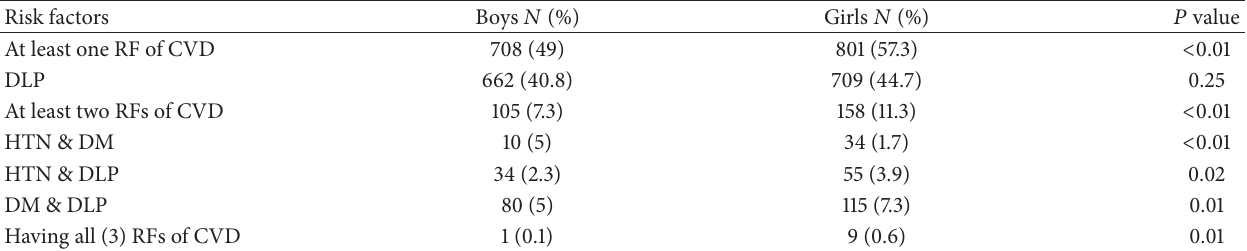
Table 2: Prevalence of cardiovascular risk factors according to gender: CASPIAN III Study.